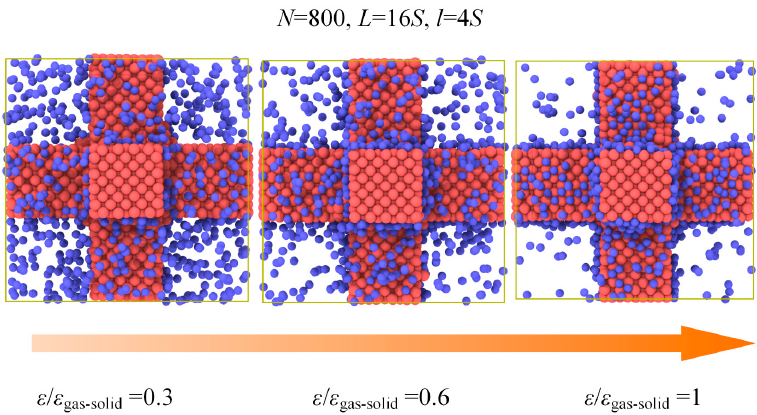
Figure 10. Gas atoms distribution for different ε under constant gas atoms number.